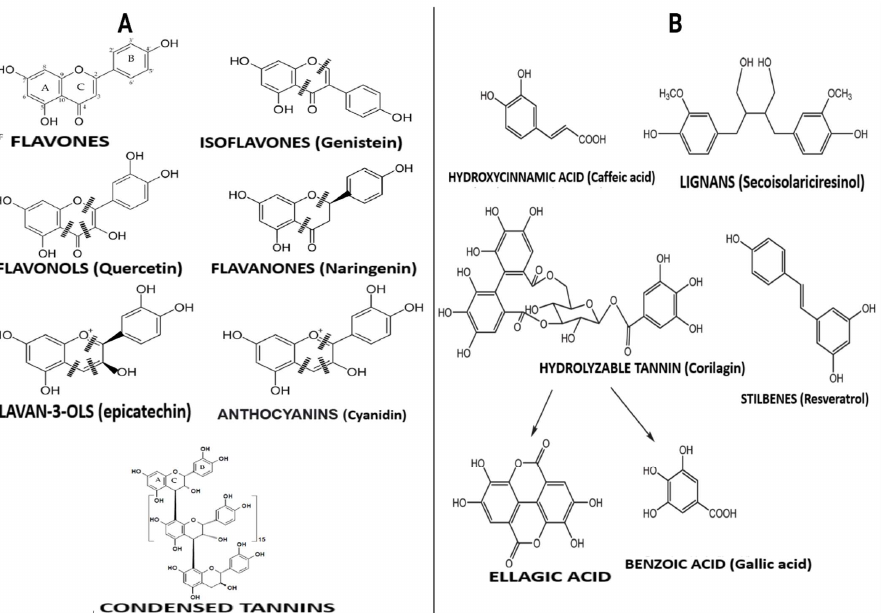
Figure 6. Flavonoids and nonflavonoid-type phenolic compounds that are metabolized by the gut bacteria. ( A ) C-ring cleavage of flavonoids. ( B ) Nonflavonoid-type phenolic compounds metabolized by the gut bacteria. Reproduced from Ozdal et al. [22]. Last accessed on 2 July 2022. In their metabolized forms, the bioavailability of polyphenols is improved, and they can effectively reach the target site of the disease and exert health benefits. In fact, the anti- obesity ability of most polyphenols is based on the properties of their end product of me- tabolism. Thus, most of the products of polyphenol metabolism by gut microbial have been reported to possess anti-obesity effects. Products from epicatechin metabolism such as 1,3,5-Trimethoxybenzene have been shown to inhibit adipocyte differentiation, while